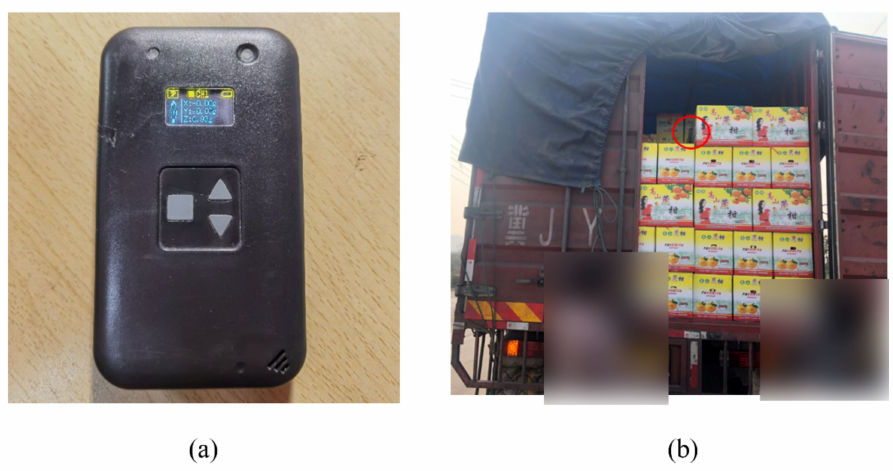
Figure 4. Truck acceleration collection test: ( a ) Accelerometer. ( b ) The position of the accelerometer in the